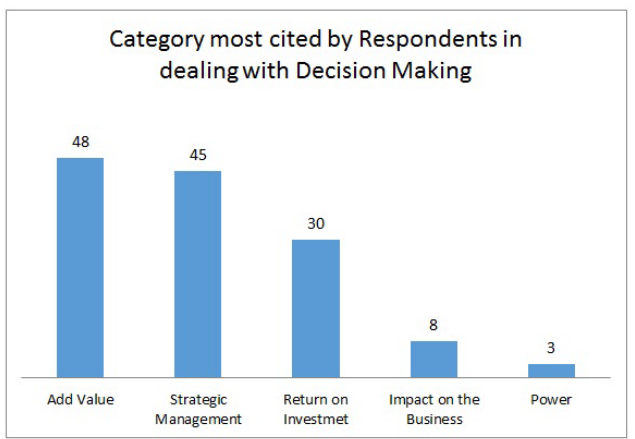
Figure 6. Category most cited by Respondents in dealing with